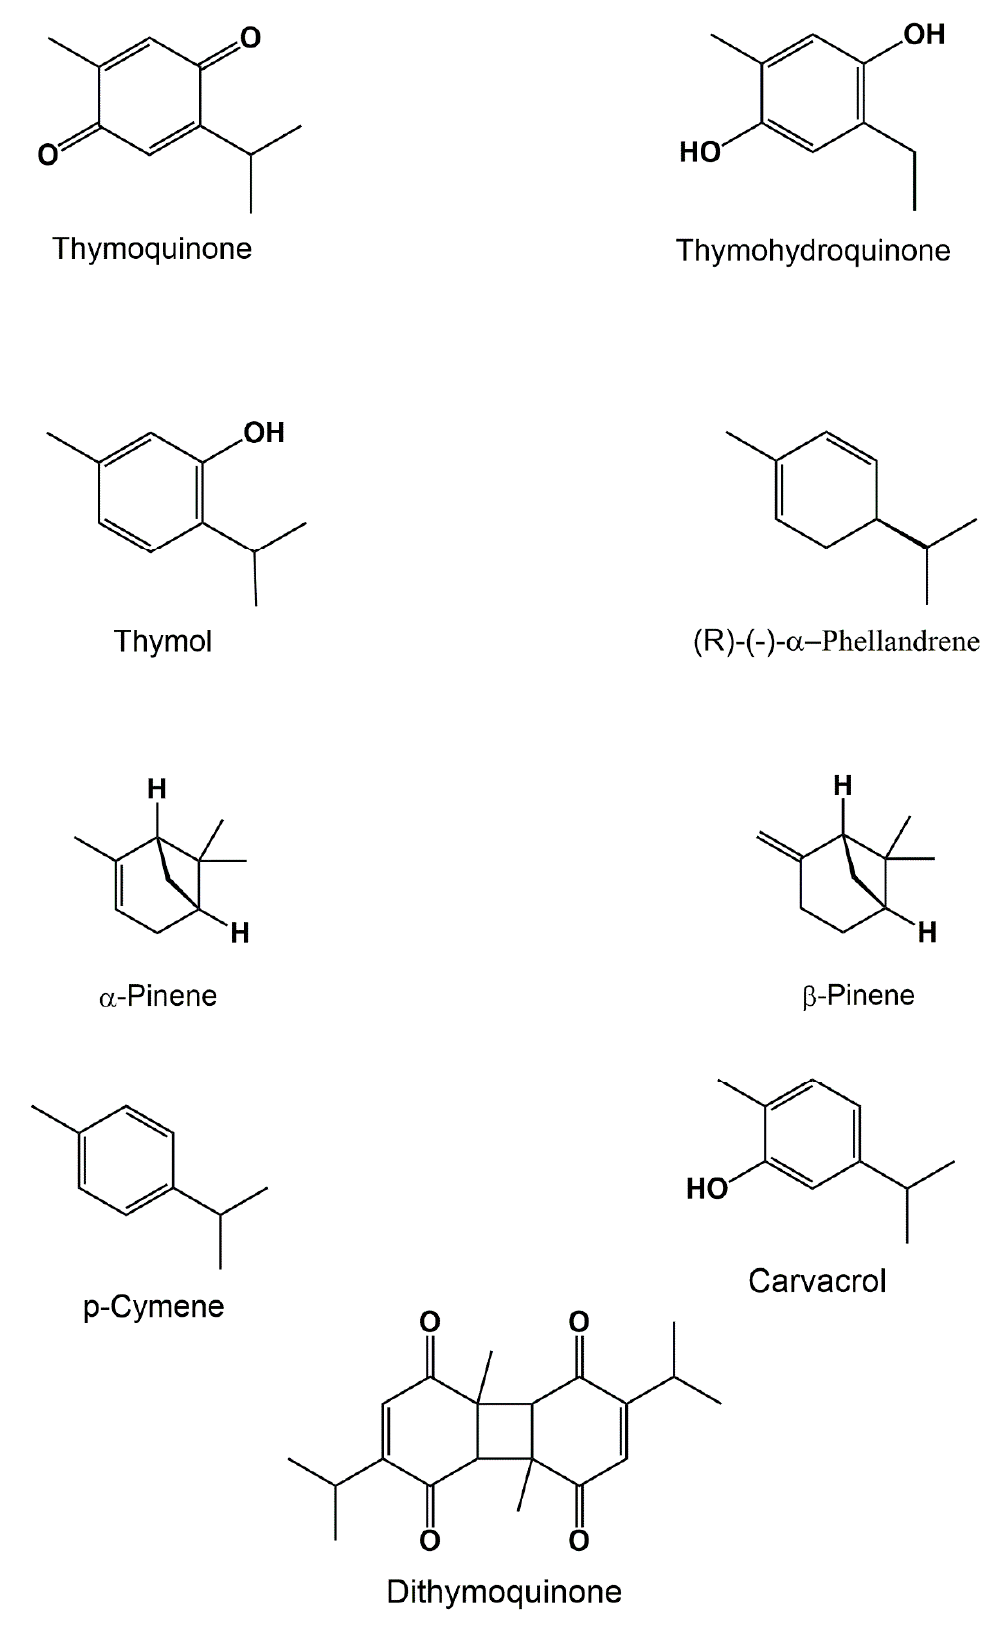
Figure 1. Some of the chemical compounds identified in the black cumin seeds using the GC-MS.